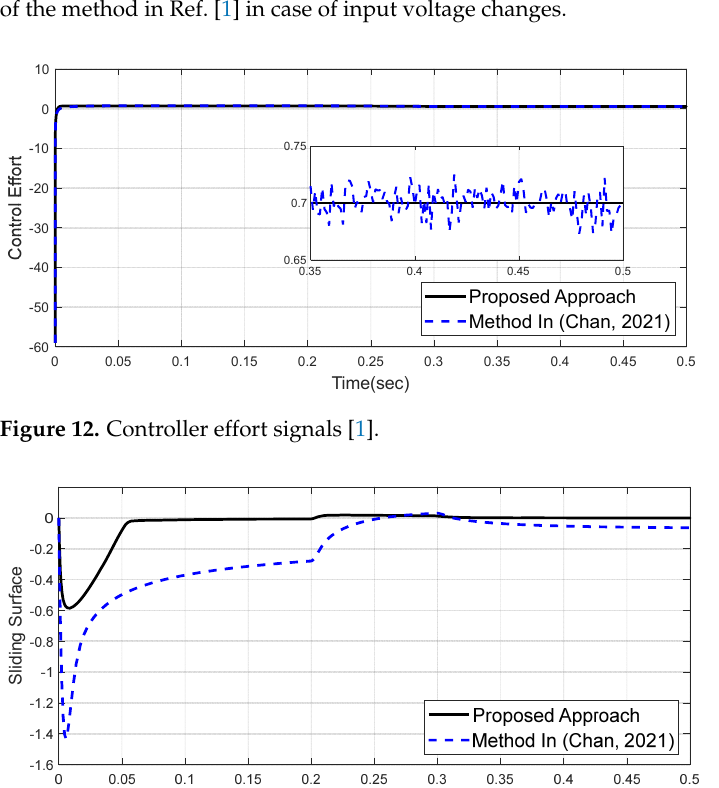
Table 3. Comparing the responses of the DBC system under the conditions of scenario 3. (cid:1) Scenario 3 Figure 13. Sliding surfaces [1] . Proposed Approach The method in Ref. [1] 𝑥 (cid:2869) (cid:4666)(cid:3047)(cid:4667)